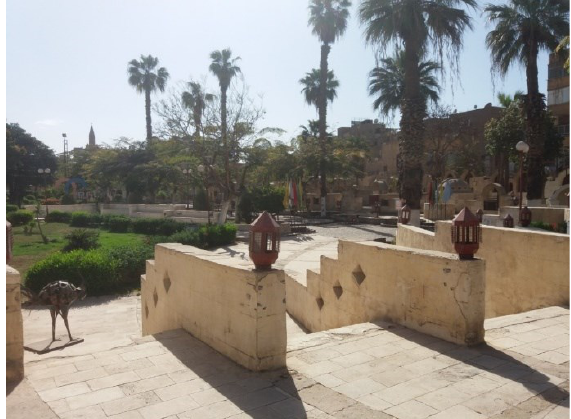
Figure 9 : View inside the Park on the weekend holiday, Authors, 2018.